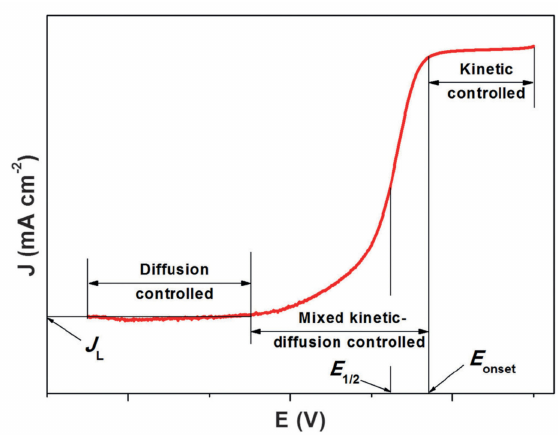
Figure 3. Typical ORR polarization curve. Reprinted with permission from [39]. Copyright 2016 John Wiley and